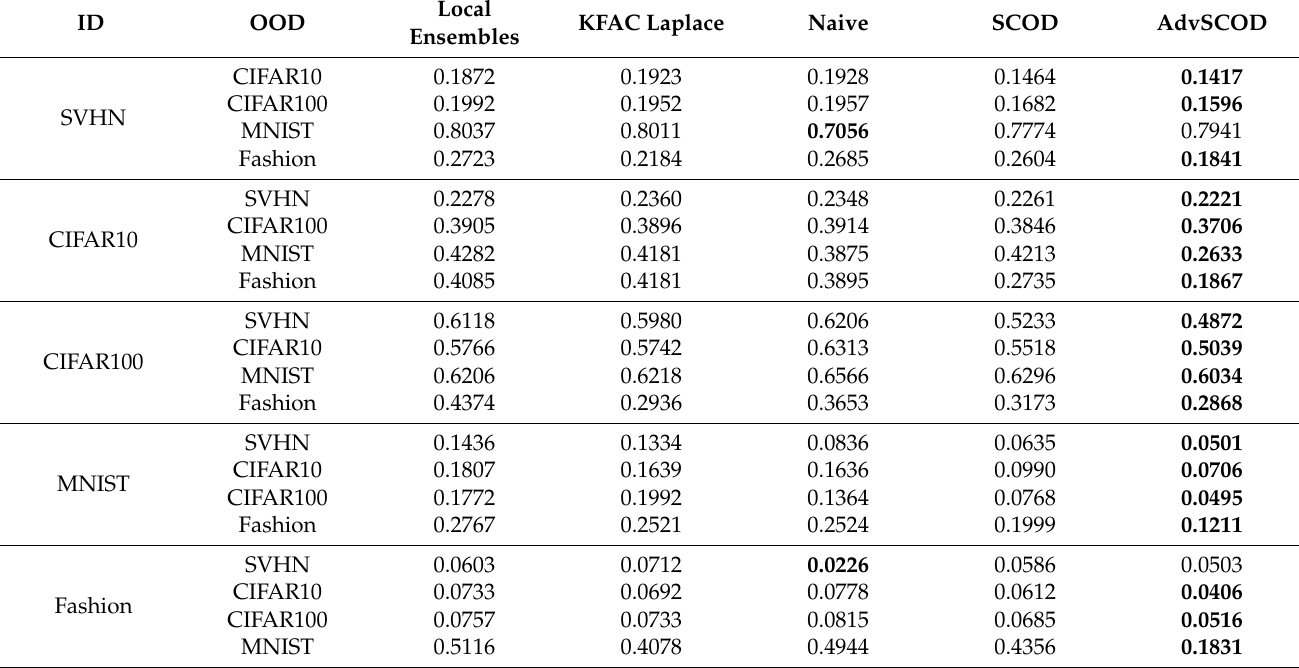
Table 3. Comparison of the OOD detection performance measured by FPR95 (lower value is better). Bold numbers are superior results.